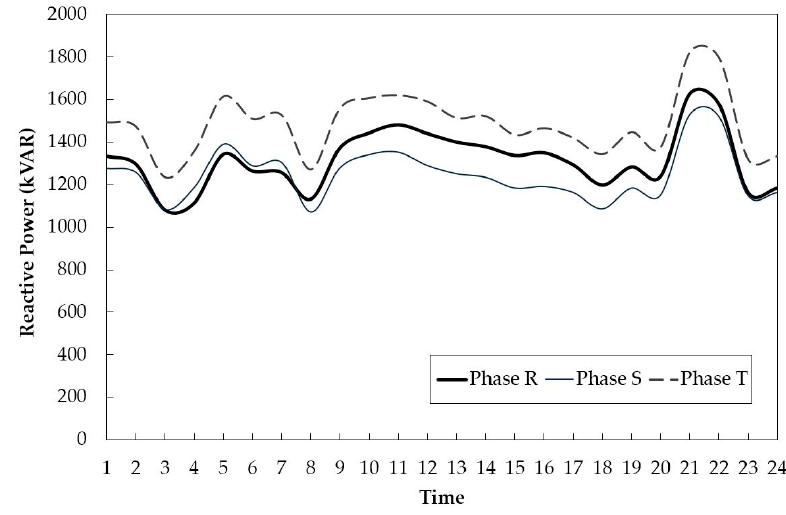
Figure 11. Daily unbalanced three-phase reactive power consumption at Bus 1.